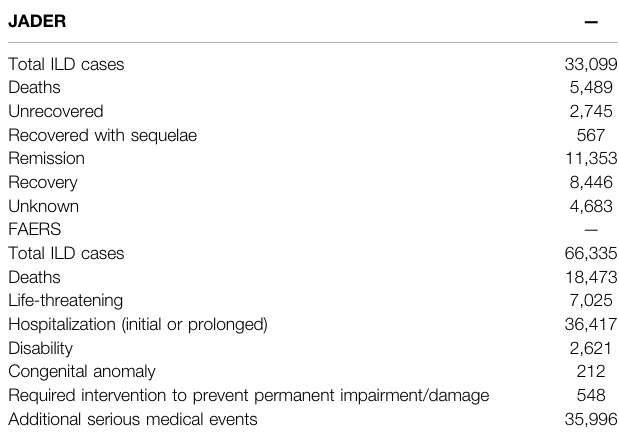
TABLE 2 | Outcomes in patients with interstitial lung